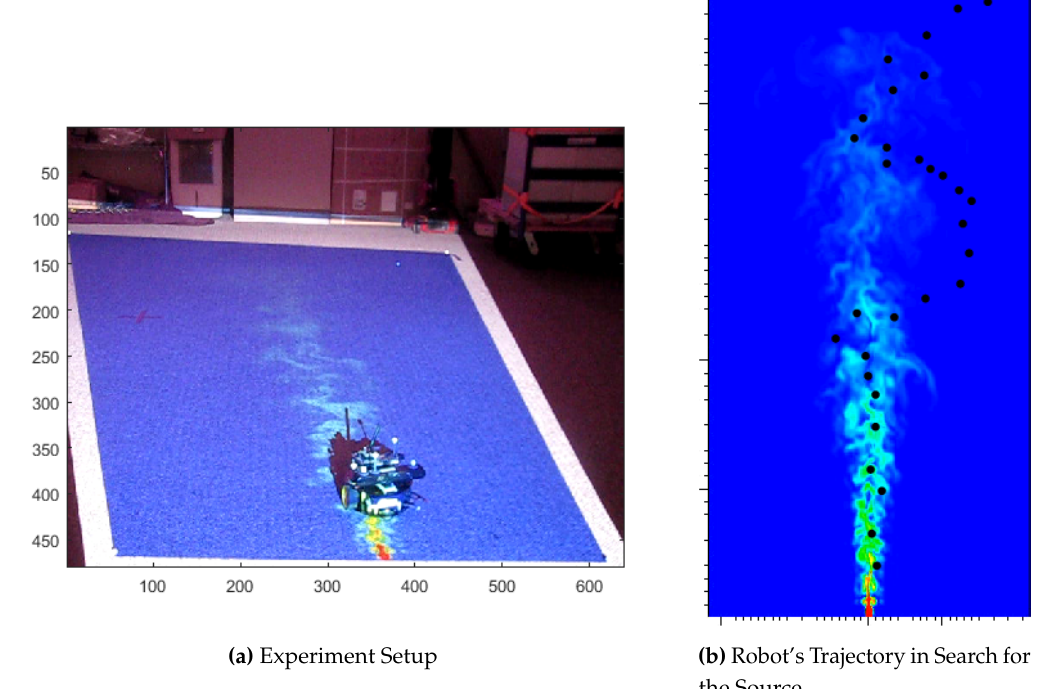
Figure 11. The experimental setup ( a ) to search for the source of oil spill. The robot is searching for the source of oil spill simulated to predict the behavior of the 2010 spill in Deep Horizon ( b ). The position of the mobile robot is observed with motion capture cameras, and connected to the computer over the network. The Robot Operating System (ROS) environment is managing the data transfer and control of the robot. The algorithm is implemented by Matlab